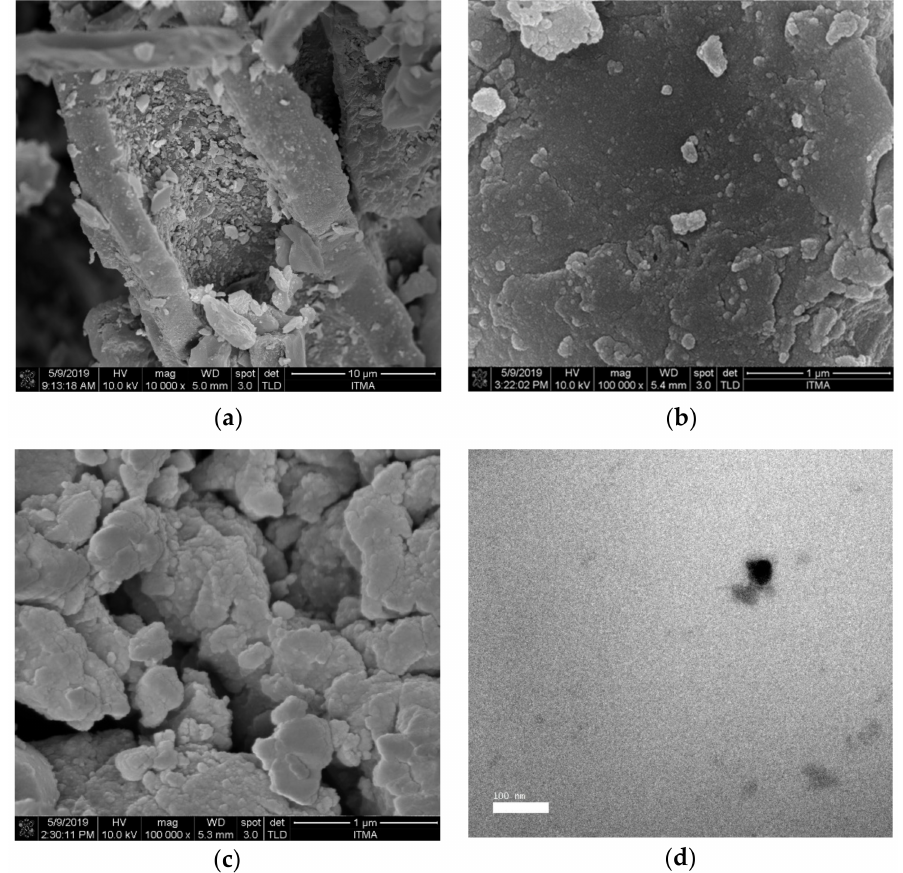
Figure 1. FESEM micrographs of biochar samples before and after ball milling; ( a ) OPEFB biochar (10k × magnification); ( b ) 60NBC (100k × magnification); ( c ) 360NBC (100k × magnification); ( d ) TEM micrograph of 60NBC (25k ×